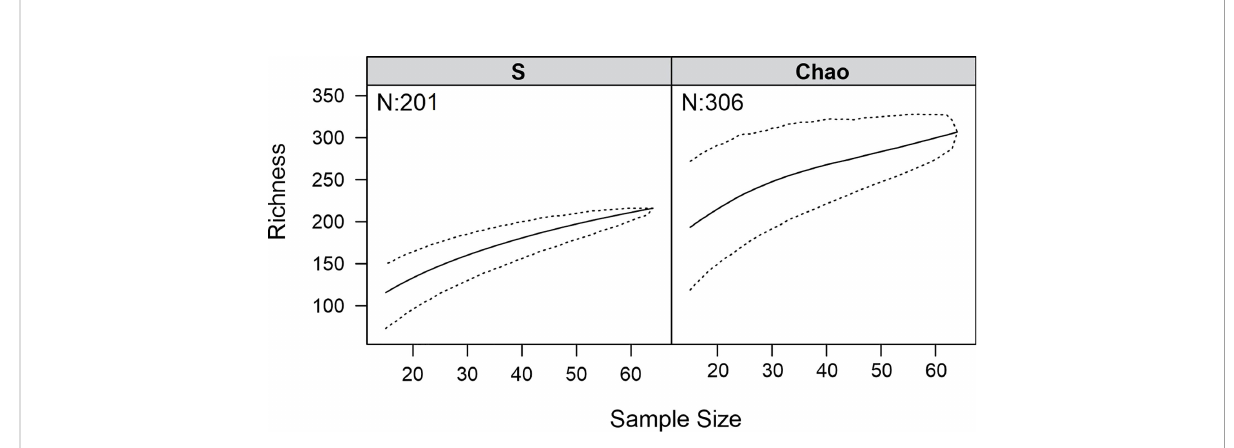
FIGURE 2 Species accumulation (S) and Chao1 estimator for ABRACOS 1 and 2 together. Dashed lines represent the con fi dence interval of